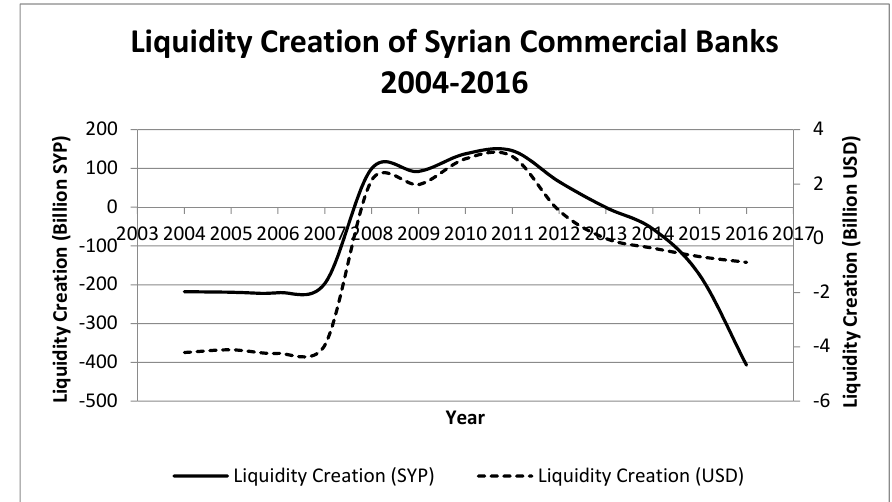
Figure 2. Liquidity creation of Syrian banks. Note: The figure shows the liquidity creation of Syrian banks measured by “cat fat” spanning the period 2004–2016.